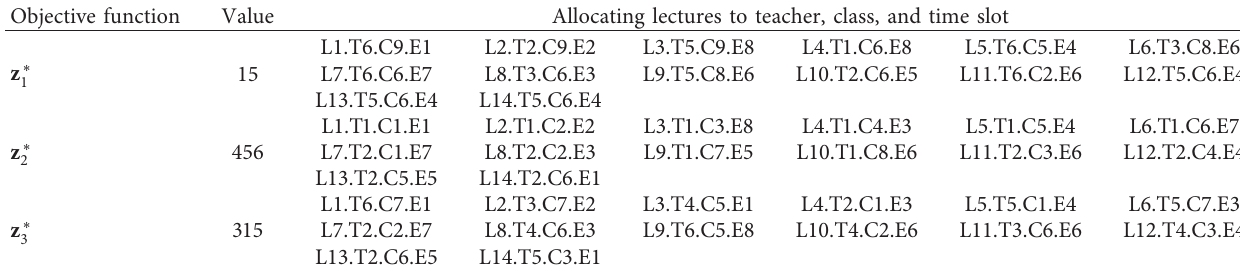
Table 16: Outcomes of the optimized model.